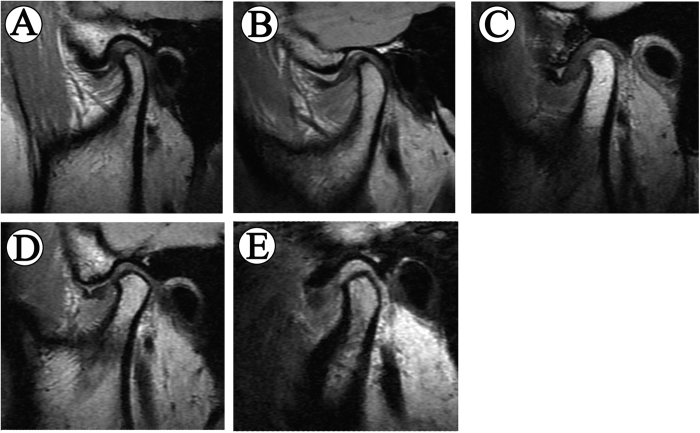
Different types of disc morphology.(A) Type I: biconcave shape, (B) Type II: biconcave shape with pseudo-disc changes, (C) Type III: V-shaped folded configuration without distinct reduce in disc length, (D) Type IV: folded and shortened disc with inadequate length to cover the condylar head, (E) Type V: rounded configuration.